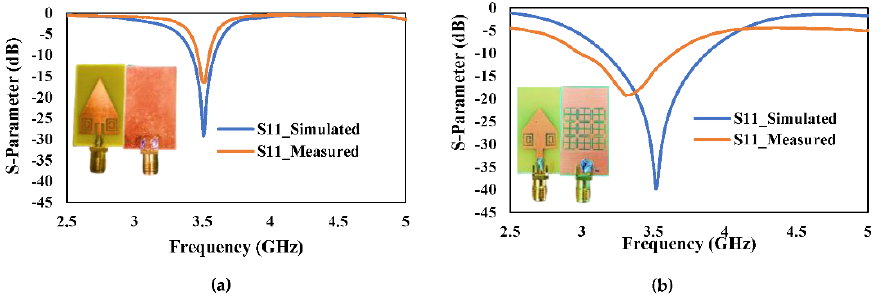
Figure 16. Simulated and Measured S-Parameter response ( a ) Proposed antenna with the complete ground plane ( b ) Proposed antenna with 3 × 3 cross-slot MTM structure etched on the ground